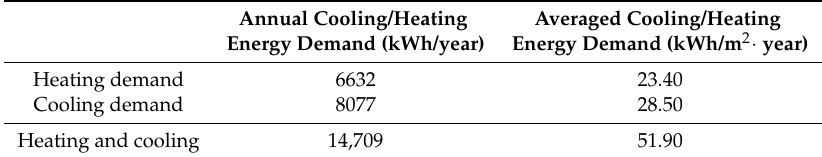
Table 6. Heating/cooling energy demand, Tangier (Morocco)—Scenario 1.